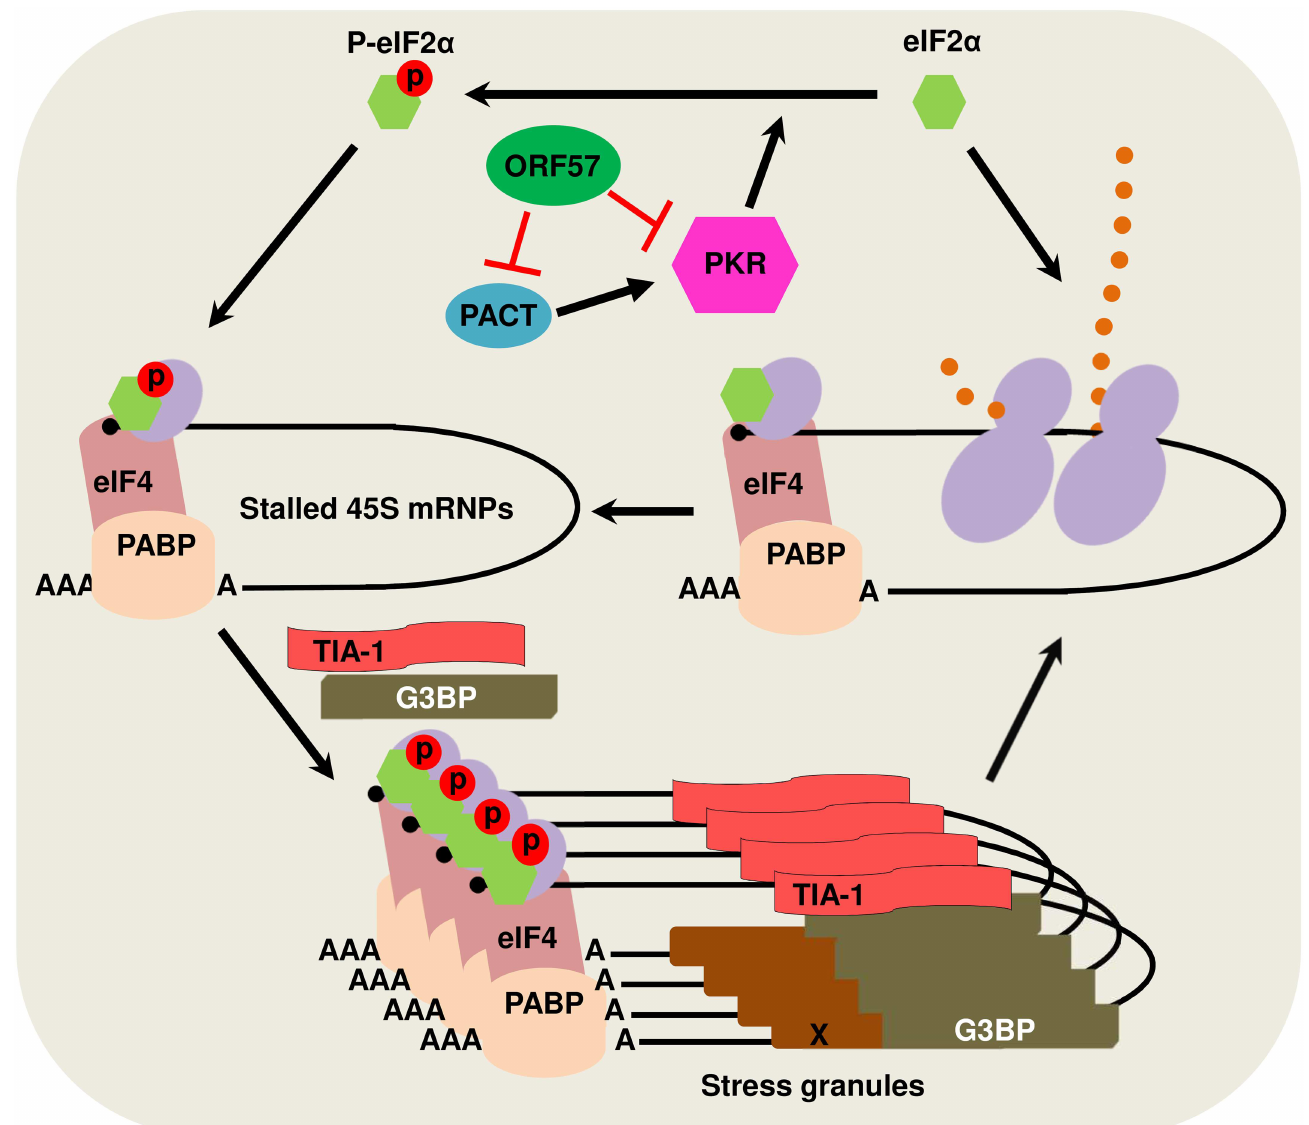
Fig 12. A schematic model showing KSHV ORF57 interactions with PACT and PKR in blocking phosphorylation of PKR and elF2 α and inhibition of SG formation. In this model, ORF57 exerts no direct effect on eIF2 α , nor its phosphorylation once PKR becomesactivated and phosphorylated. Orange dots, elongating polypeptidechain from translating polysomes; X, other protein factors in stress granules.